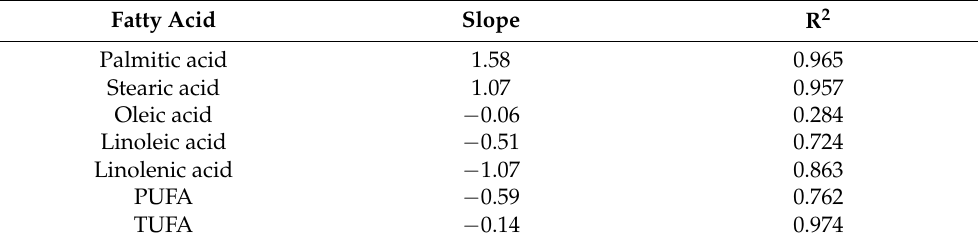
Table 2. The fitting results of fatty acids’ change with time during